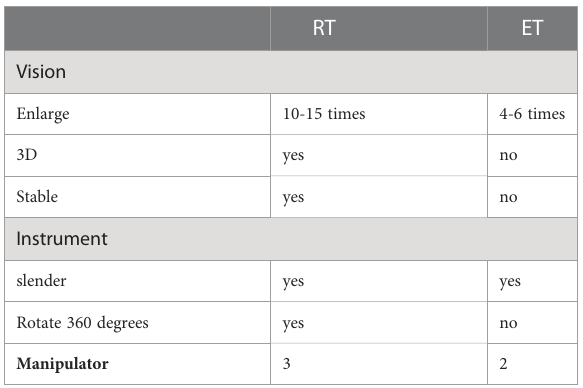
TABLE 2 The main differences between the two technologies.